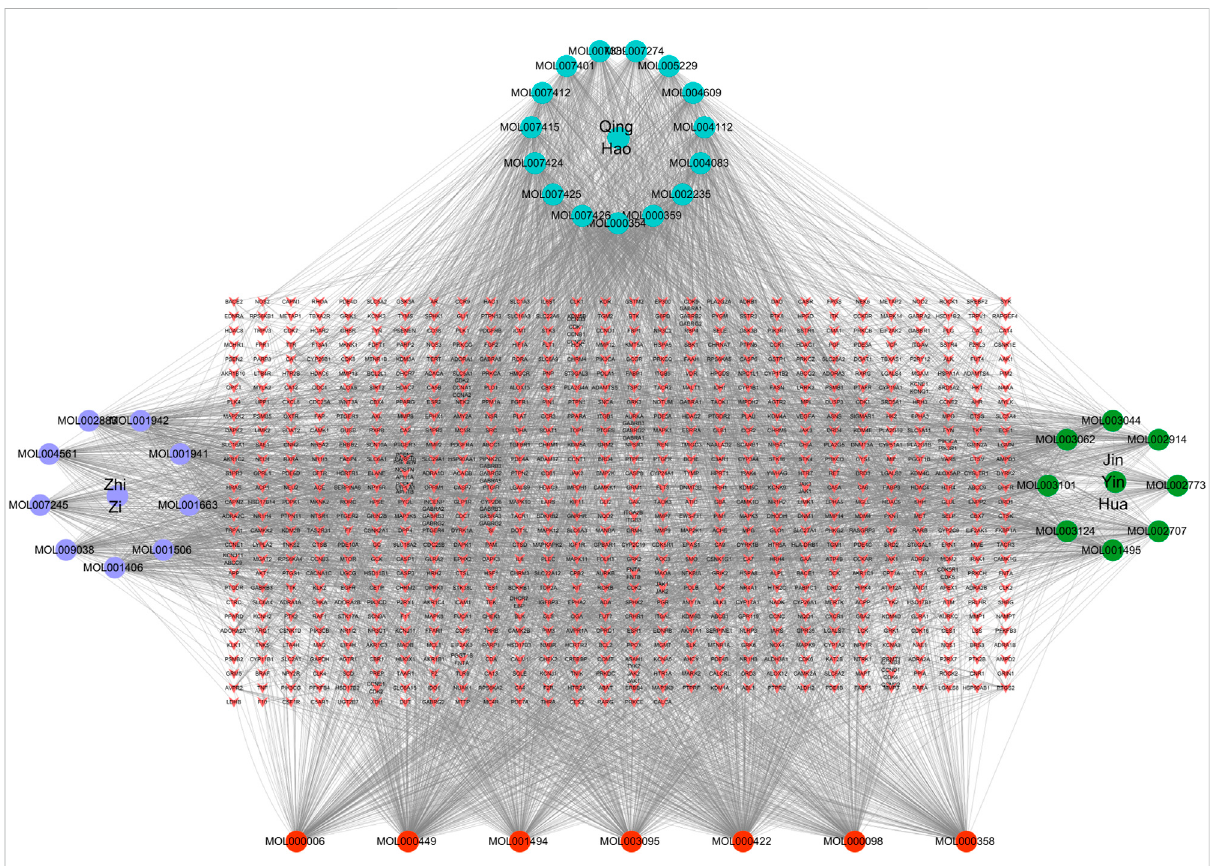
FIGURE 2 TCM – component – target – diseasenetwork.Inthenetwork,thepurple,green,andcyancirclesaretheTCMandthethreecorrespondingherbs, and the red circles are the compounds common to the three herbs. The targets corresponding to the active ingredients form the red inverted triangle.